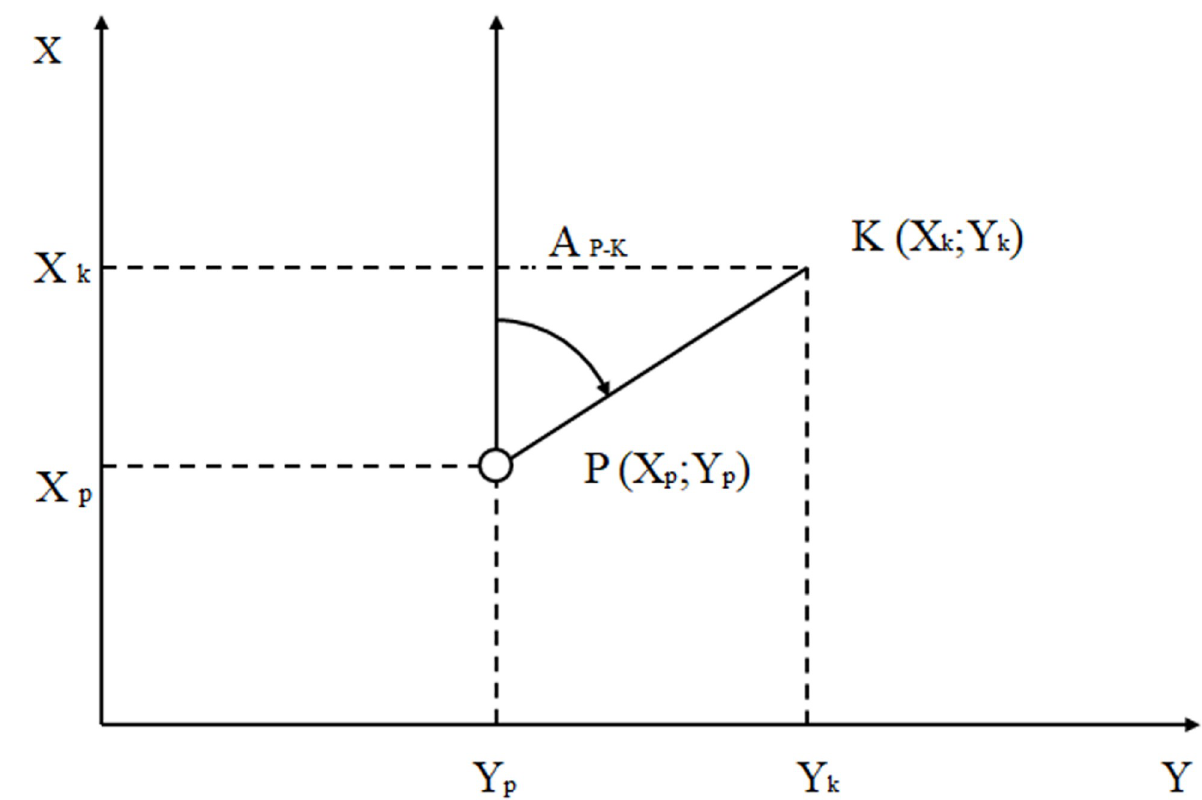
Fig 4. A schema for calculating an azimuth (A P-K ) between points P (Xp, Yp) and K (Xk, Yk). Reference axes are swapped to the counter clockwise mathematical polar coordinates.